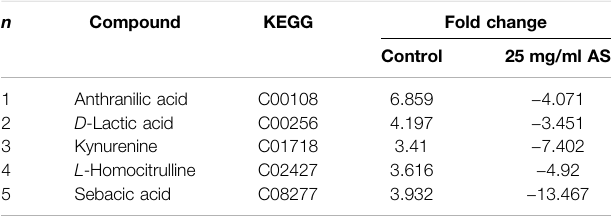
TABLE 4 | Common terminal metabolites re fl ecting bio fi lm formation and AS ef fi